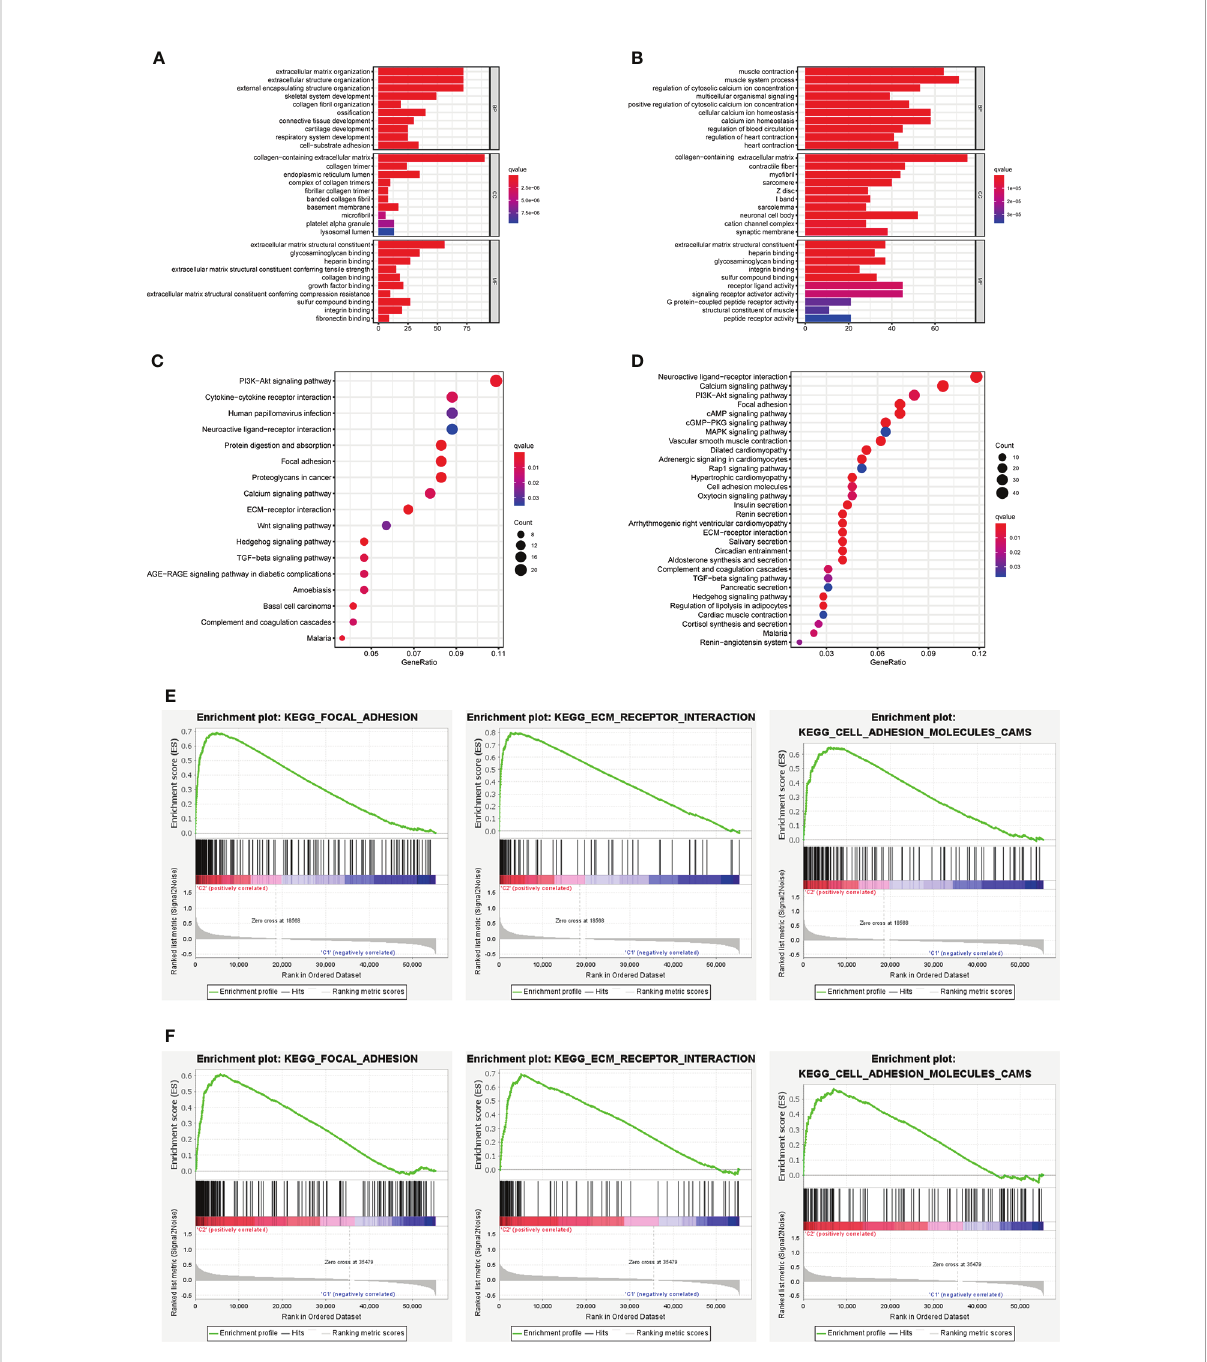
FIGURE 13 Biological functional analysis. (A, B) The bar plot of GO analysis in DEGs between different clusters and different risk subgroups. (C, D) The bubble plot of KEGG pathways analysis in DEGs between different clusters and different risk subgroups. (E, F) GSEA analysis for cluster II and high-risk